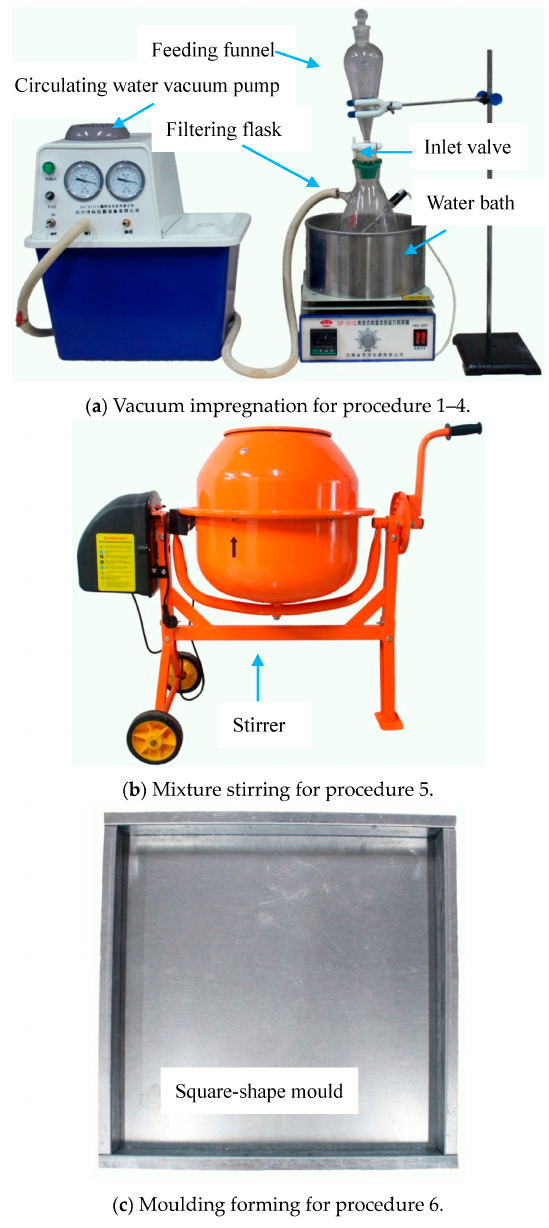
Figure 2. Schematic diagram of the novel PCMP preparation.